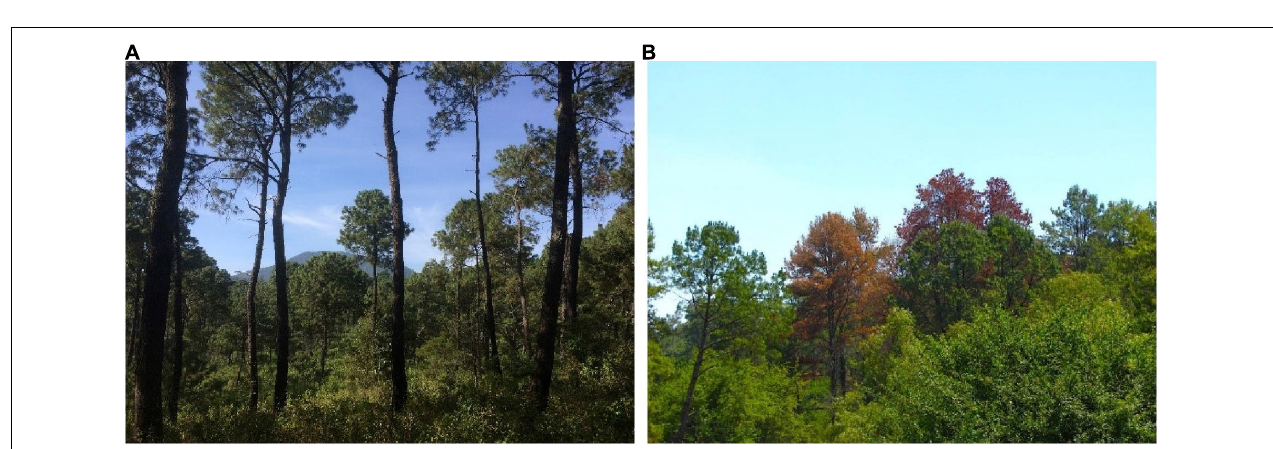
FIGURE 3 | (A) Location of Jalisco state in Mexico (B) . Location of the Sierra del Tigre study site within Jalisco, and (C) . location of degradation plots (red points) within Sierra del Tigre.% forest cover for the year 2010 across Mexico taken from Hansen et al. (2013).